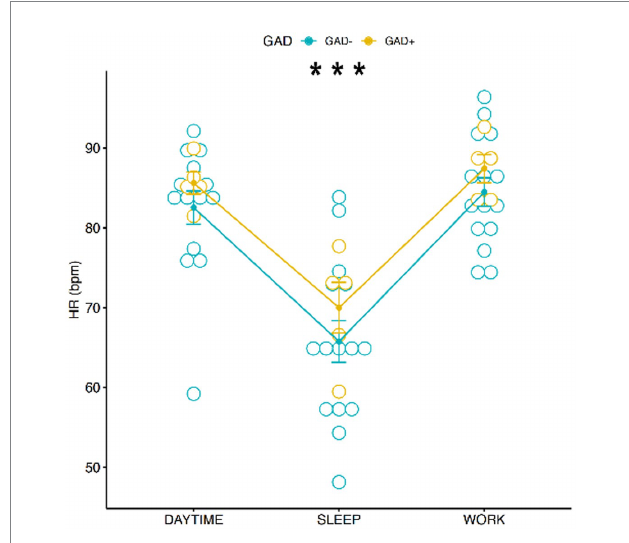
FIGURE 5 Graphic distribution of HR values during the 3 conditions according to GAD ±. *** = p < 0.0001.